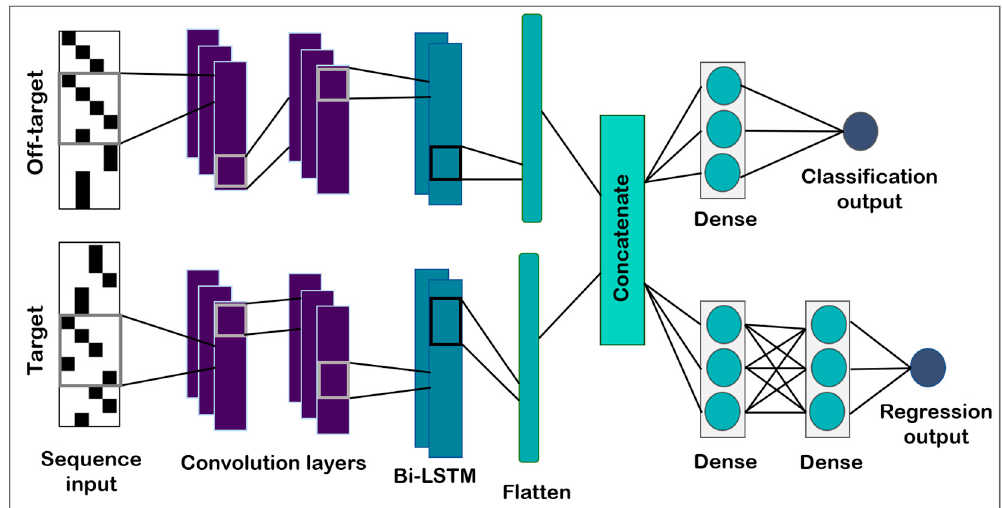
Figure 1. CRISP–RCNN model architecture. Representative target and off-target sequences are depicted as input for the model. The input is fed into convolution layers, followed by an LSTM layer. The two branches are then concatenated and fed into two separate but fully connected dense layers, which perform the classi fi cation and regression tasks.